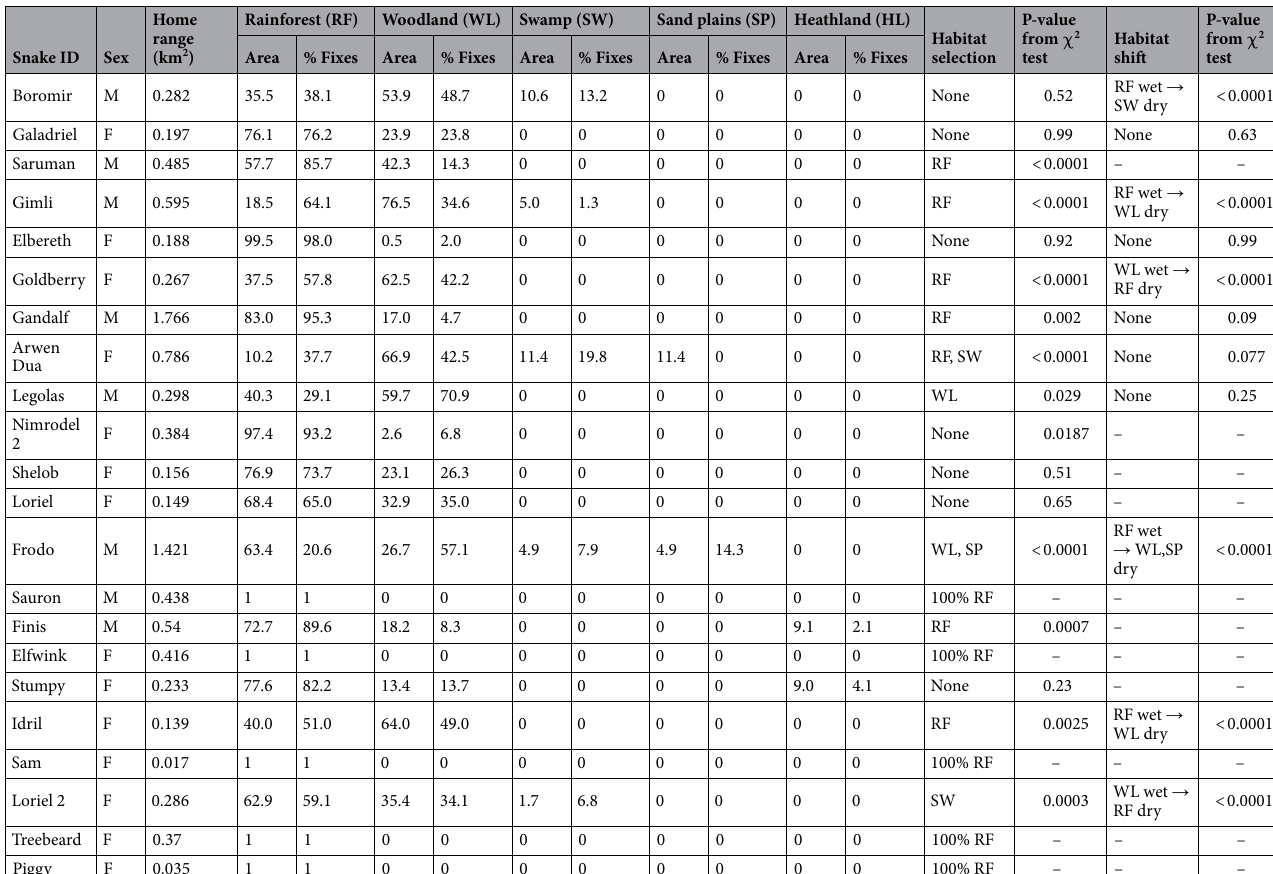
Table 2. Habitat associations of scrub pythons ( Simalia amethistina ) in Cape York showing the relative proportion of each habitat type in the home range of telemetered pythons and the proportion of total fixes that were made in those habitat types. Habitats selected more frequently than expected from their overall availability are shown together with the P-values for χ 2 significance tests. If no habitat preference was observed for an individual python it is recorded as ‘none’. If the analysis could not be completed because only one habitat type was available in the home range it is recorded as ‘100% rainforest’. Seasonal shifts in habitat use and the direction of the shift are shown, along with the P-values for the χ 2 significance test. For example, ‘RF wet → SW dry’ records a habitat shift from rainforest in the wet season to swamp in the dry season. Regional Ecosystems for each habitat type are provided below the table. See “Methods” for details of the calculation of these results. RF: Regional ecosystem 3.5.3 (Semi-deciduous notophyll vine forest of the Carnegie tableland) and 3.2.1 (Evergreen notophyll vine forest in coastal dunefield systems). WL: Regional ecosystem 3.5.5(a) ( Corymbia novoguinensis + /− C. tessellaris woodland on sand plains on northern Cape York Peninsula).